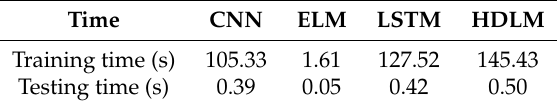
Table 2. Training and testing time of all models.